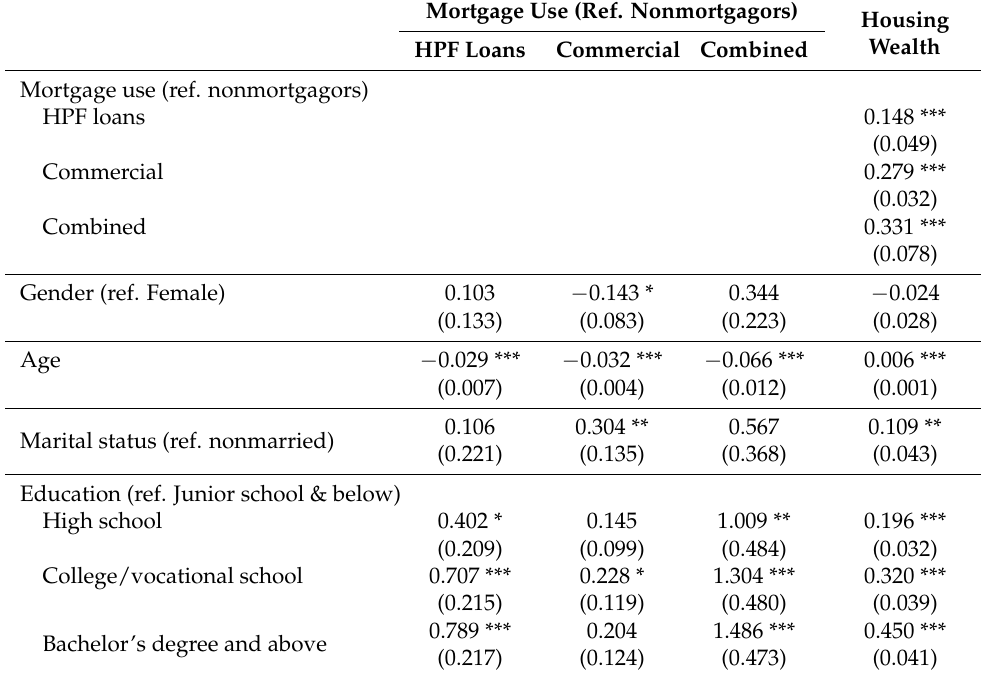
Table 2. The results of the generalized structural equation